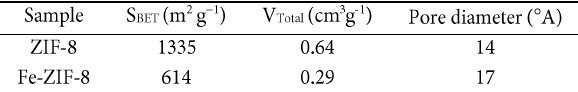
Fig. 2 The XRD patterns of nanocatalysts. Fig. 3. Nitrogen adsorption/desorption isotherms of ZIF-8 and Fe-ZIF-8a Table 1. Textural properties of ZIF-8 and